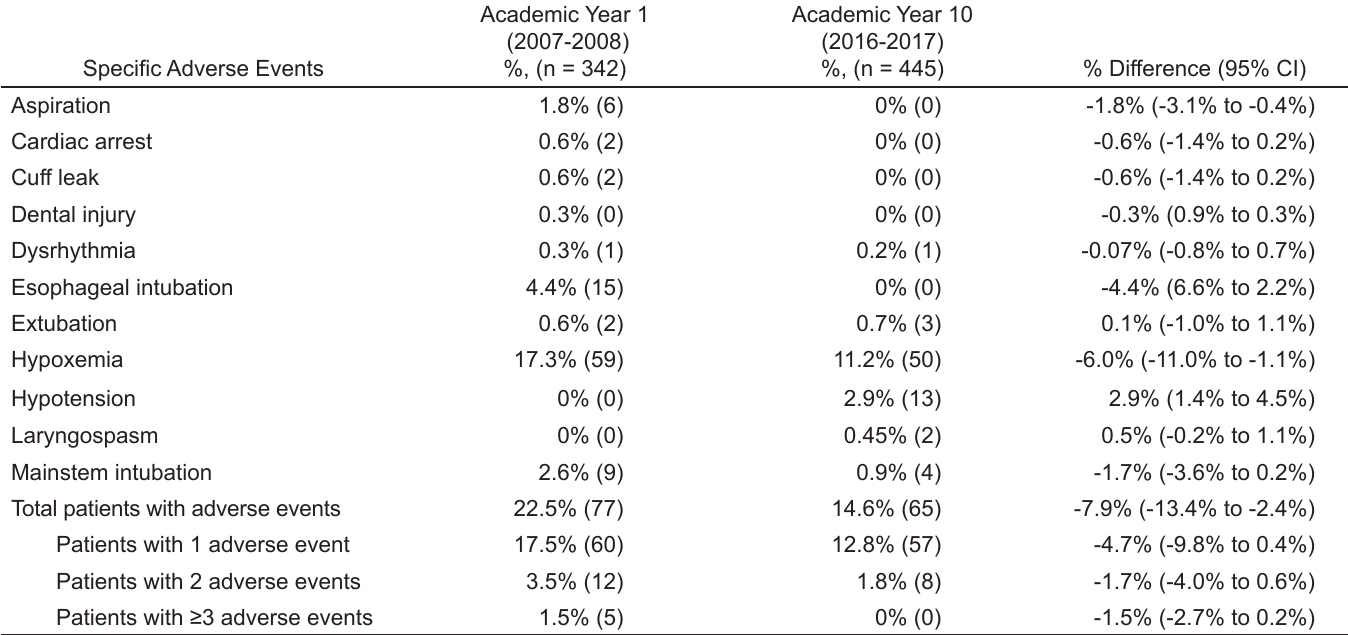
Table 4. Adverse intubation events in Academic Year 1 versus Academic Year 10.